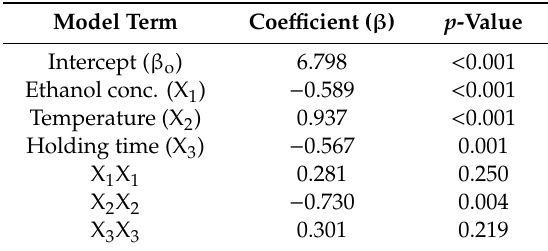
Table 2. Calculated regression coe ffi cients for terms in the multiple linear regression model (Equation (4)).